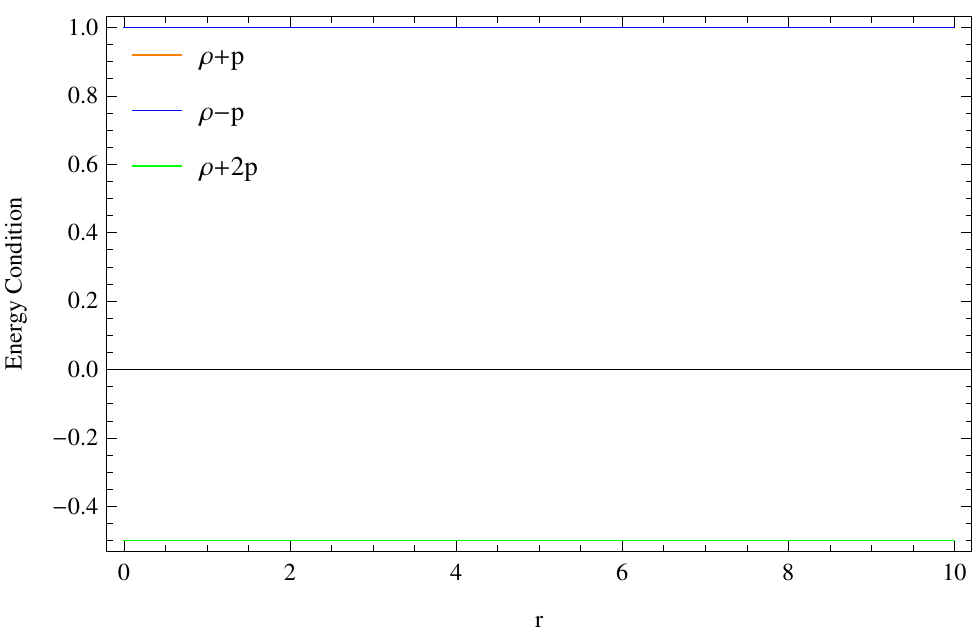
Figure 9. The energy conditions are plotted against the radial parameter r , for dark energy matter ( ω = − 1), and for the values of constants C 1 = 0.01, C 2 = 0.5, C 3 = 2.